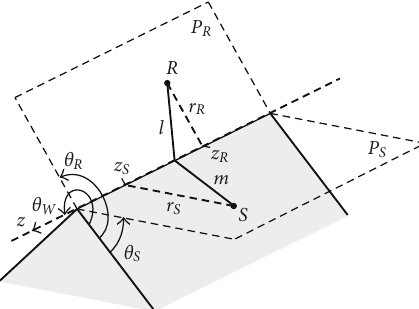
Figure 1: Wedge geometry and coordinate system. Locations are specified in cylindrical coordinates where r is the radial distance from the edge, θ is measured from one of the two wedge faces, and the z -axis is aligned with the edge. P S and P R are virtual half-planes that contain S and R , respectively, and the